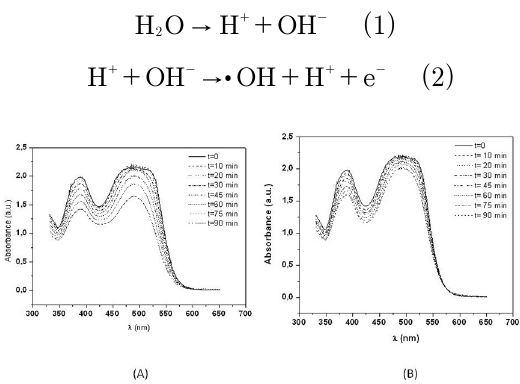
Figure 4. Absorption spectra of RO16 dye solutions at 50 mA cm -2 (a) H SO and (b) HClO , as a function of electrolysis 2 4 4